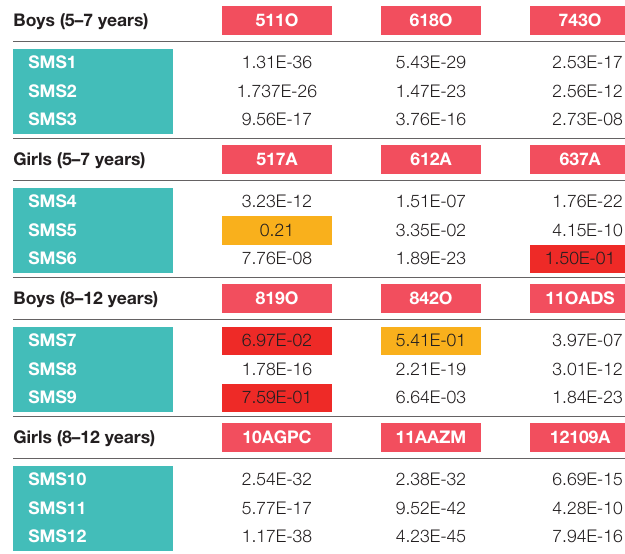
TABLE 3 | values comparison of cepstral peak prominence (CPP) with T- and U